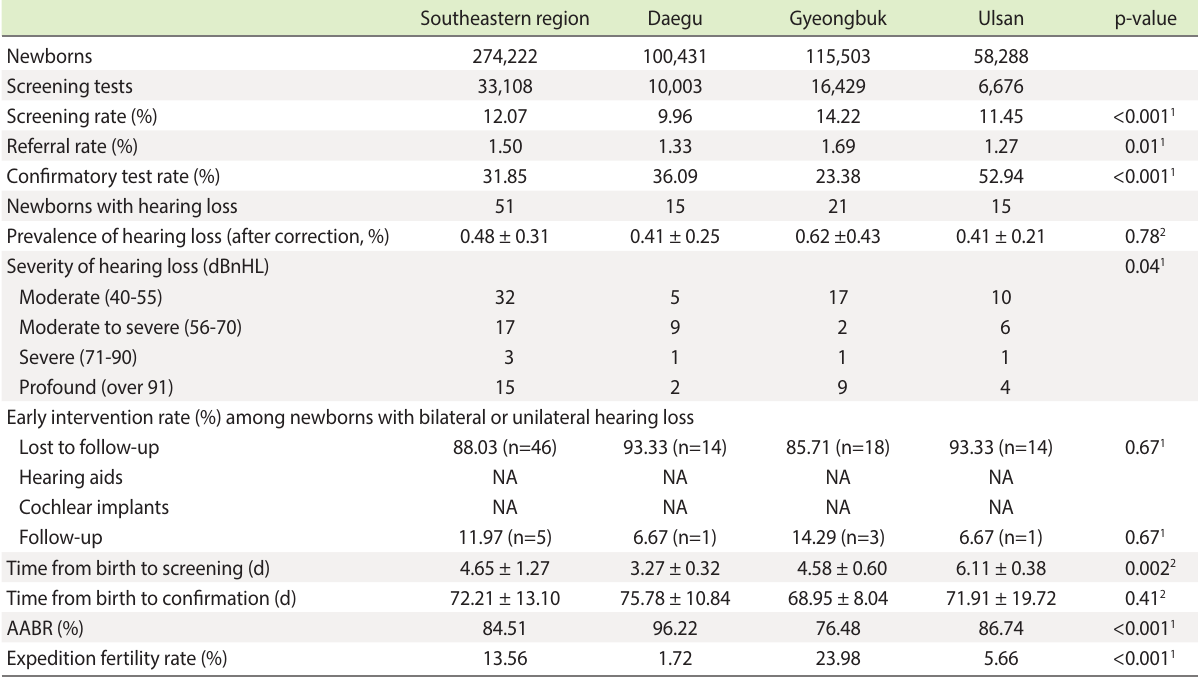
Table 1. Data of newborn hearing screening in Daegu, Gyeongbuk, and Ulsan